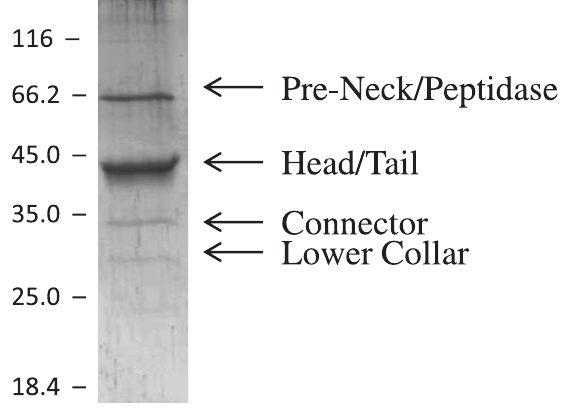
Figure 4. Polyacrylamide Gel Electrophoresis of Virion Proteins from Purified Bacteriophage W CP7R. Bacteriophages were purified by isopycnic centrifugation through CsCl followed by electrophoresis in a 10% SDS-PAGE. Size markers are on the left and regions of proteins identified mass spectrometry are on the right side of the figure.